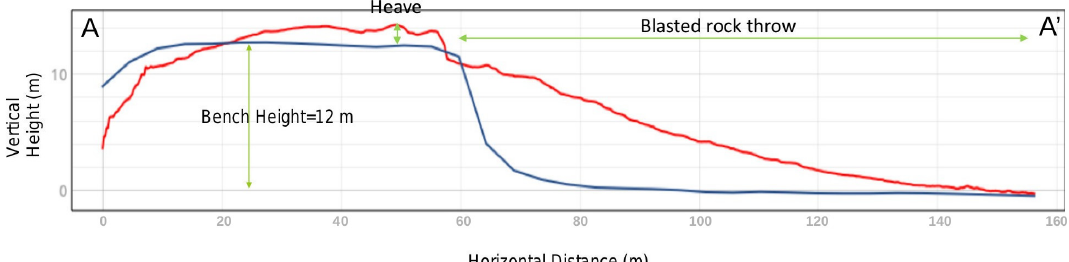
Figure 17. Section through muck pile with blue showing the pre-blast and red the post-blast DEM